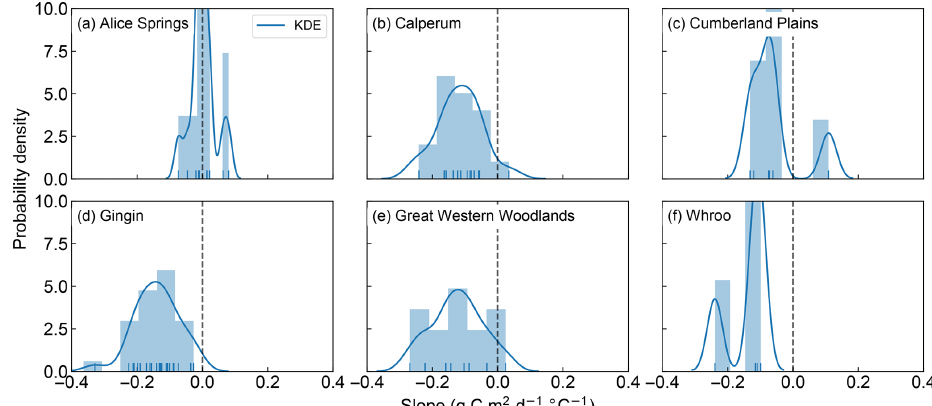
Figure 3. Probability density and histogram showing the distribution of fitted positive and negative GPP slopes across the OzFlux sites. The dark blue curve shows the fitted kernel density estimate (KDE) and the vertical blue lines along the x axis are “rugs”, which represent the individual occurrence of fitted slopes. Data from Wombat State Forest have been omitted from the graph as there was only one slope. Note that the sum of the bars can exceed 1 as the normalization ensures that the sum of the bar heights multiplied by the bar widths equals 1, which allows the normalized histogram to be compared to the KDE, which is normalized so that the area under the curve equals 1.